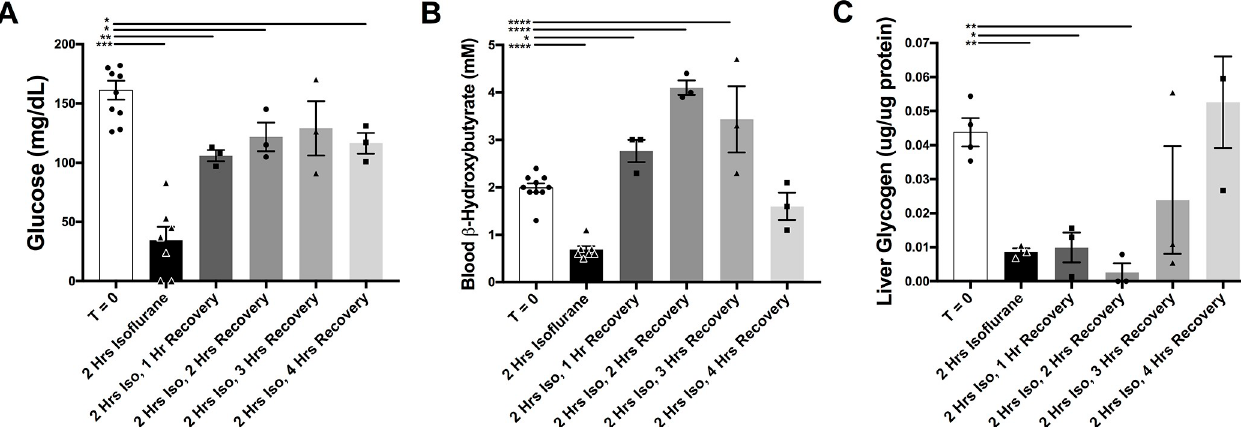
Fig 2. Metabolic recovery timeframe in P7 neonates anesthetized for 2 hours. ( A ) P7 mouse blood glucose concentration at baseline, at 2 hours of anesthesia with 1.5% isoflurane, and at 1 to 4 hours of recovery from 2 hours of anesthesia (baseline and 1-hour timepoints also in Fig 1 ). ANOVA p-value < 0.0001; � p < 0.05, �� p < 0.005, ��� p < 0.0005 by post-hoc pair-wise t-tests. n = 10, 7, 3, 3, 3, and 3 for baseline, 2 hours exposure, and 1, 2, 3, and 4 hours post-exposure, respectively. ( B ) P7 mouse blood ß-hydroxybutyrate concentration at baseline, at 2 hours of anesthesia with 1.5% isoflurane, and at 1 to 4 hours of recovery from 2 hours of anesthesia. ANOVA p-value < 0.0001; � p < 0.05, ���� p < 0.0001 in post-hoc pair-wise t-tests. n = 10, 7, 3, 3, 3, and 3 for baseline, 2 hours exposure, and 1, 2, 3, and 4 hours post-exposure, respectively. ( C ) Liver glycogen concentration at baseline, at 2 hours of anesthesia with 1.5% isoflurane, and at 1 to 4 hours of recovery from 2 hours of anesthesia. ANOVA p-value < 0.0001; � p < 0.05, �� p < 0.005, ��� p < 0.0005 in post-hoc pair-wise t-tests. n = 4, 3, 3, 3, 3, and 3 for baseline, 2 hours exposure, and 1, 2, 3, and 4 hours post-exposure, respectively. Each data-point represents an individual animal; error bars depict SEM. Baseline and 1-hour timepoints in ( A ) and ( B ) also in Fig 1 .